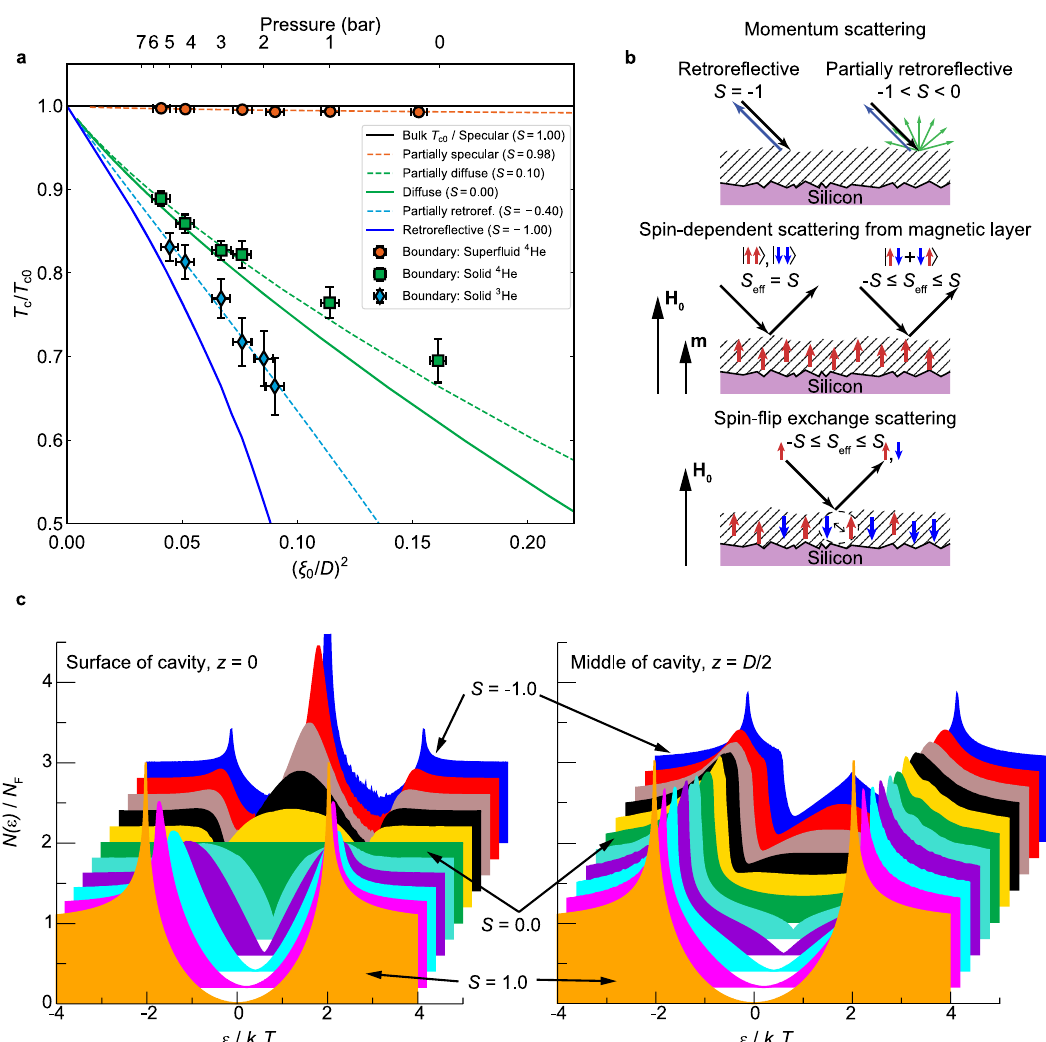
Fig. 3 Increased suppression of super fl uid transition temperature in presence of a magnetic solid 3 He surface boundary layer. a Suppression of T c in cavity relative to that of bulk liquid as a function of square of the inverse effective cavity height D / ξ 0 , for solid 3 He boundary (diamonds), solid 4 He boundary (squares), and super fl uid 4 He boundary (circles). Full lines show: maximal pair-breaking retrore fl ection ( S = − 1); diffuse ( S = 0); fully specular ( S = 1). Dashed lines show best fi ts to the data: S = − 0.4, 0.1, 0.98. For the solid 3 He boundary, T c is identi fi ed from onset of super fl uid frequency shift after correcting for background frequency shift arising from magnetic solid layer (Supplementary Note 5). The vertical and horizontal error bars re fl ect the uncertainties in temperature determination and the height range of the pressure-distorted cavity, respectively ( ‘ Methods ’ ). b Three candidate scattering mechanisms for negative effective specularity (see also Supplementary Note 6): retrore fl ection (ruled out by normal state measurements); spin-dependent pair breaking on scattering from a magnetically polarized layer (absent for the relative orientation of surface layer spin polarization m , surface normal, and spin orientation of A-phase pairs in our set-up); spin- fl ip exchange scattering (spin polarization of surface layer can be zero). Here the effective specularity S eff is a parameter characterising combined magnetic and momentum scattering, bounded by the specularity alone. c Calculated density of states (DOS) N ( ε ), where ε is the quasiparticle energy, of 3 He-A at the surface and in the middle of the cavity, scaled with the normal state DOS, N F , and averaged over the full Fermi surface. These calculations correspond to pure momentum scattering between specularities S = − 1.0 and S = 1.0, with step size 0.2 between successive colours. The calculations were performed for cavity height D / ξ The density of zero-energy bound states increases throughout the cavity as the specularity The fact that momentum scattering with the pre-plated solid 4 He surface boundary layer is close to diffuse contrasts with the signi fi cant specularity we infer in the pure 3 He case from our model of magnetic surface scattering. The replacement of surface 3 He by 4 He relies on the differential surface binding energy of the two isotopes due to differences in zero-point energy. It appears